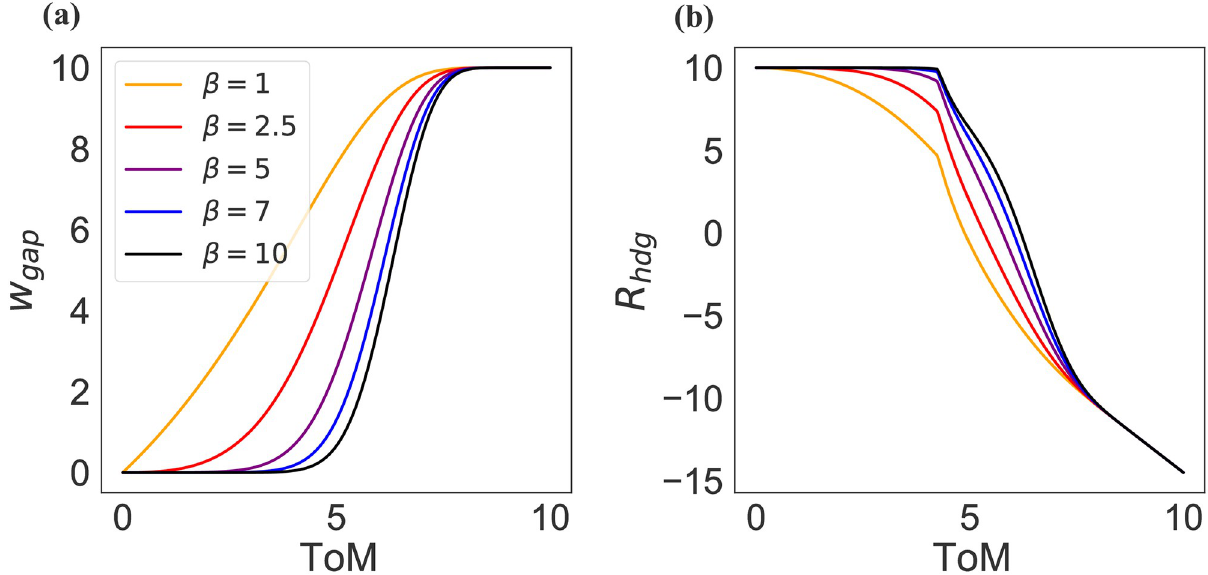
Fig 3. (a) Effect of group characteristics β and theory of mind ( ToM ) on the ability of groups to close representational gaps ( w harness the benefits of representational diversity ( R ). The higher the level of β the higher are distrust and fractured identities and the higher the hdg minimum level of ToM required to reduce representational gaps and harness the benefits of diversity in an action situation. Figure was generated keeping E = S = cpx cpx